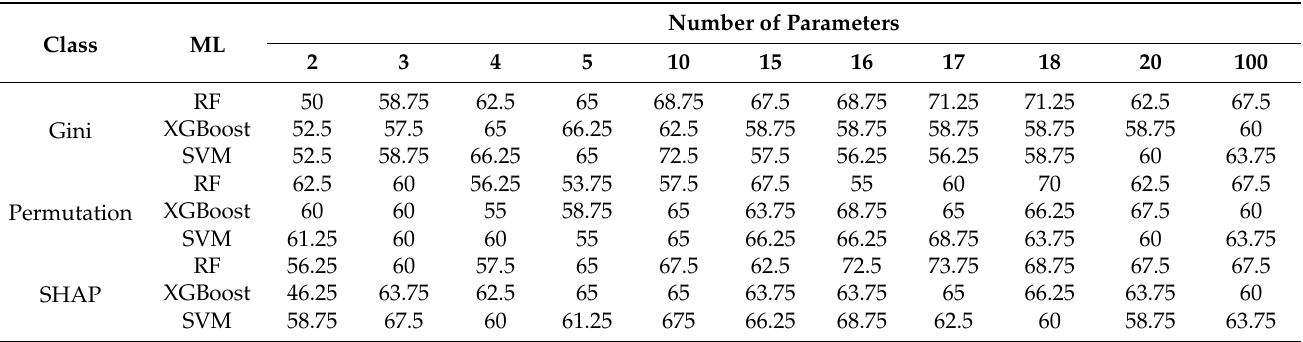
Table 8. Sarcopenia identification results according to the number of important parameters (accu- racy, %).